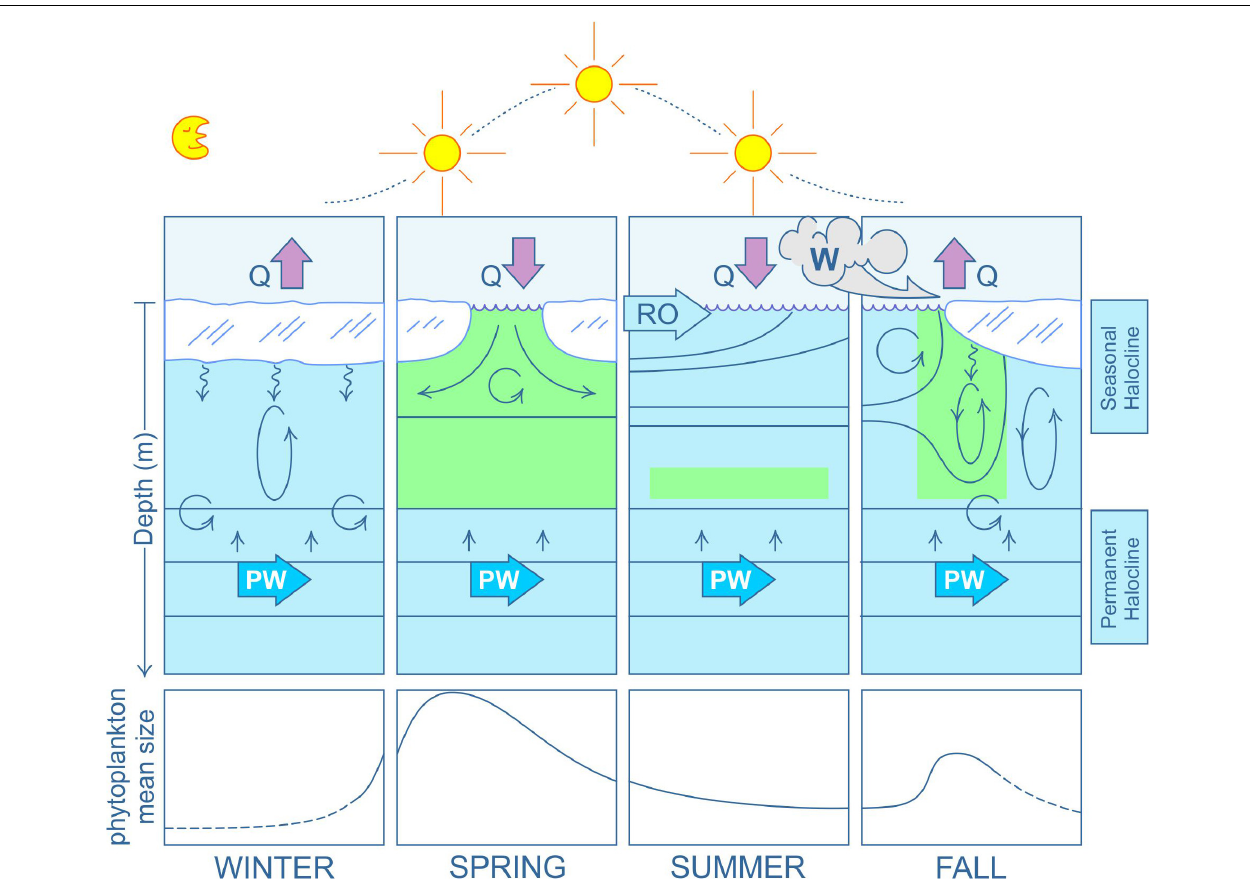
FIGURE 3 | Seasonal evolution of the Arctic Ocean “lids.” Cartoon depicting an idealized, 1-D seasonal progression of upper ocean stratification through the freeze-melt sea ice cycle, illustrating the formation of the seasonal halocline and its separation from the permanent halocline complex below. The structures shown are specific to the Amerasian Basin, but analogous reasoning holds for the Eurasian Basin. Here, vertical block arrows denote net heat flux (Q) out of (winter and fall) and into (spring and summer) the upper ocean; horizontal arrows labeled RO denote spreading of the runoff plume waters and horizontal arrows labeled PW denote interflowing Pacific Water; blue isolines illustrate the seasonal cycle of salinity stratification (see text); straight, upwards-directed arrows denote compensation upwelling from the PW (see text); wiggly, downward-directed arrows denote dense, brine rejection during sea ice formation (winter and fall); ellipses with arrows denote brine-driven convection; circles with arrows denote penetrative convection and entrainment across the upper boundary of the permanent halocline due to convection and shear; W is wind, shown here as intensified during fall transition. Green highlighted areas illustrate the relative location of phytoplankton biomass in the water column, while the lower panels illustrate the mean size distribution of phytoplankton within each season, based on an extrapolation of the nanoplankton/picoplankton ratio discussed by Li et al. (2009,